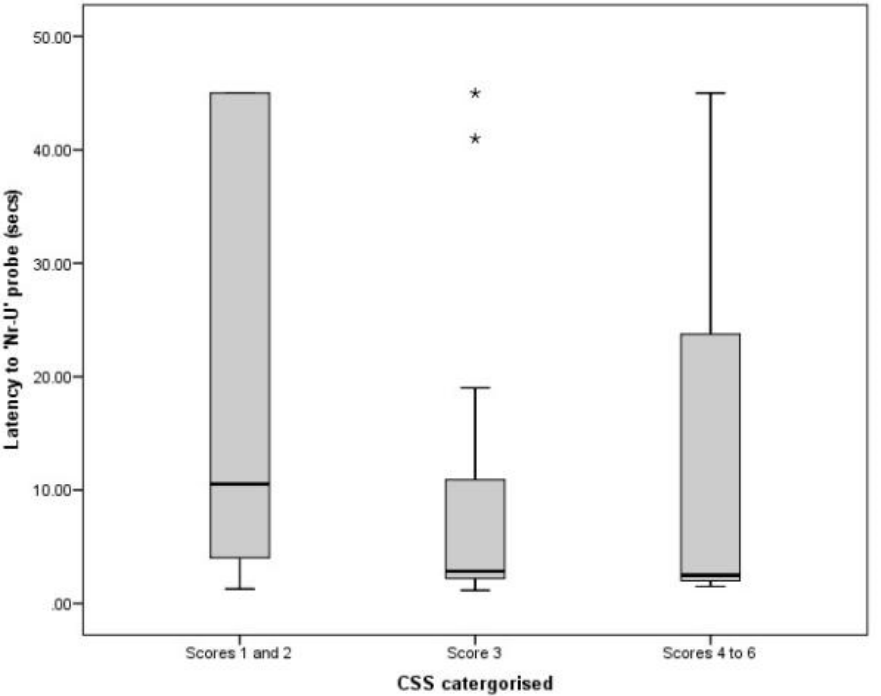
Figure 4. Box plot showing variation in latency to the near-unrewarded probe between different cat stress score categories. Extreme outliers (*) are identified.